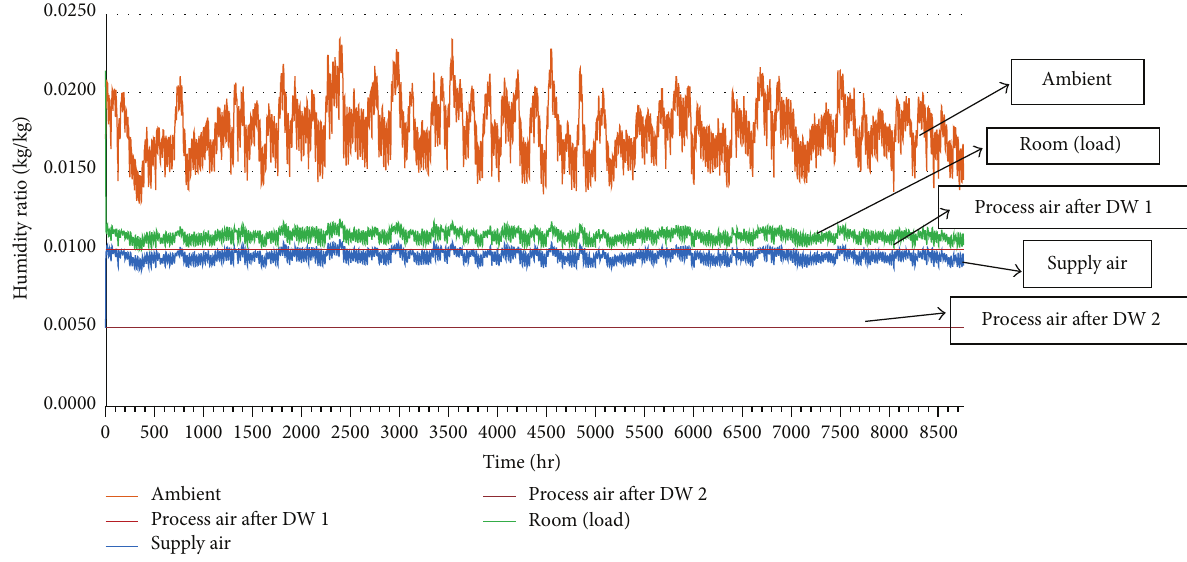
Figure 12: Humidity ratio (kg/kg) of different components versus time (hr) in two-stage ventilation desiccant cooling system.